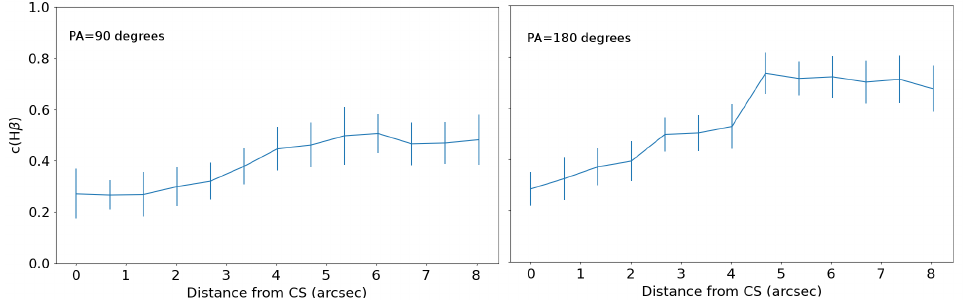
Figure 2. Radial profile of c(H β ) for Hen 2-108 along two pseudo-slits with PA of 90 °C ( left panel ) and 180 °C ( right panel